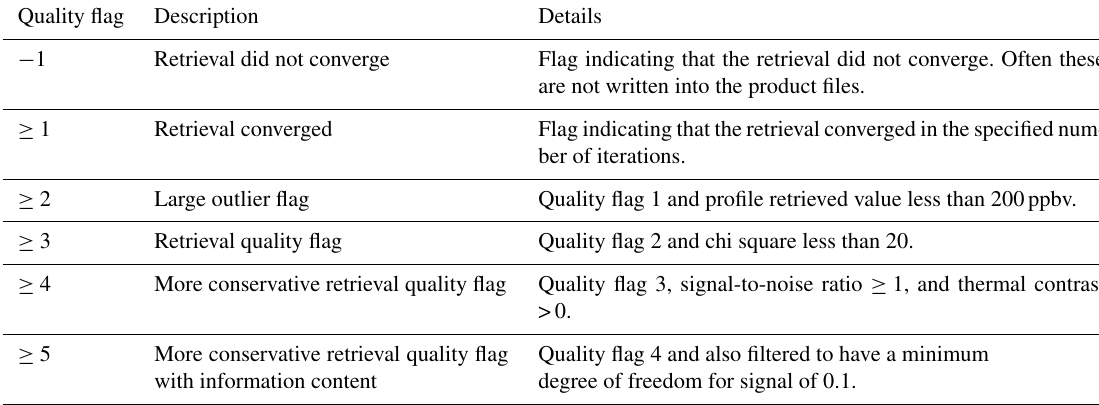
Table A1. Quality flags for version